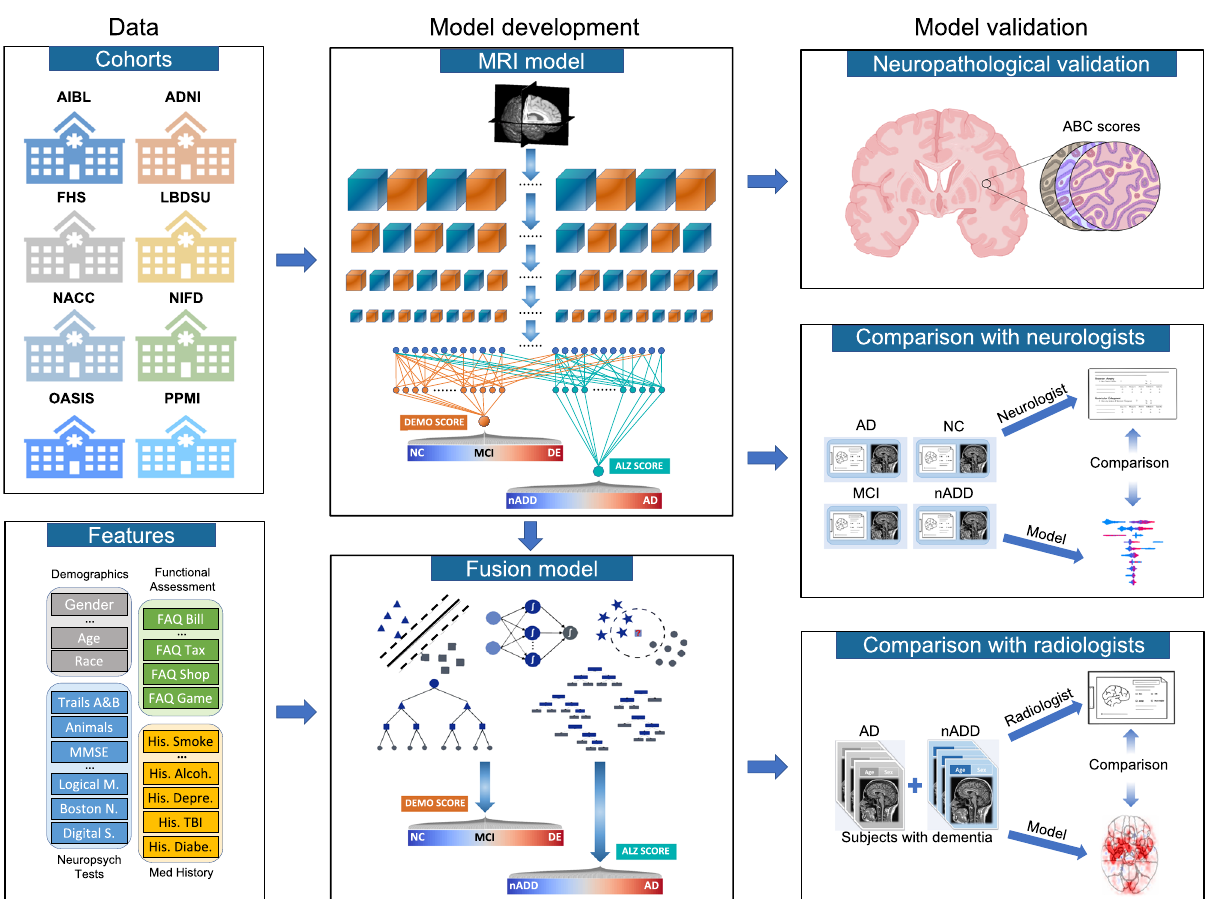
Fig. 1 Modeling framework and overall strategy. Multimodal data including MRI scans, demographics, medical history, functional assessments, and neuropsychological test results were used to develop deep learning models on various classi fi cation tasks. Eight independent datasets were used for this study, including NACC, ADNI, AIBL, FHS, LBDSU, NIFD, OASIS, and PPMI. We selected the NACC dataset to develop three separate models: (i) an MRI- only CNN model (ii) non-imaging models in the form of traditional machine learning classi fi ers, which did not use any MRI data (iii) a fusion model combining imaging and non-imaging data within a hybrid architecture joining a CNN to a CatBoost model. The MRI-only model was validated across all eight cohorts, whereas external validation of non-imaging and fusion models was performed only on OASIS. First, T1-weighted MRI scans were input to a CNN to calculate a continuous DEmentia MOdel (DEMO) score to assess cognitive status on a 0 to 2 scale, where “ 0 ” indicated NC “ 1 ” indicated MCI and “ 2 ” indicated DE. DEMO scores were converted to class labels using an optimal thresholding algorithm, with these assignments constituting the COG task. For individuals with DE diagnosis, the multi-task CNN model simultaneously discriminated their risk of having AD versus nADD, a classi fi cation that we refer to as the ADD task. We denoted the probability of AD diagnosis as the ALZheimer (ALZ) score. Both MRI-derived DEMO scores and ALZ scores were then input alongside non-imaging variables to various machine learning classi fi ers to form fusion models, which then predicted outcomes on the COG and ADD tasks, respectively. A portion of cases with con fi rmed dementia ( n = 50) from the NACC testing cohort was randomly selected for direct comparison of the fusion model with an international team of practicing neuroradiologists. Both the model and neuroradiologists completed the ADD task using available MRI scans, age, and gender. Additionally, a portion of NACC cases ( n = 100) was randomly selected to compare the fusion model performance to practicing neurologists, with both the model and clinicians having access to a common set of multimodal data. Lastly, model predictions were compared with neuropathology grades from NACC, ADNI and FHS cohorts ( n = diagnosis tasks (Table 2). We found strong model performance on the COG NC task between both the NACC test set (Fig. 3a, Row 1) and an external validation set (OASIS; Fig. 3b, Row 1) as indicated by area under the receiver operating characteristic (AUC) curve values of 0.945 [95% con fi dence interval (CI): 0.939, 0.951] and 0.959 [CI: 0.955, 0.963], respectively. Similar values for area under precision-recall (AP) curves were also observed, Relative to the fusion model, we observed moderate perfor- yielding 0.946 [CI: 0.940, 0.952] and 0.969 [CI: 0.964, 0.974], mance reductions across classi fi cations in our MRI-only model. respectively. Such correspondence between AUC and AP per- formance supports robustness to class imbalance across datasets. In the COG DE task, comparable results were also seen, as the fusion model yielded respective AUC and AP scores of 0.971 [CI: